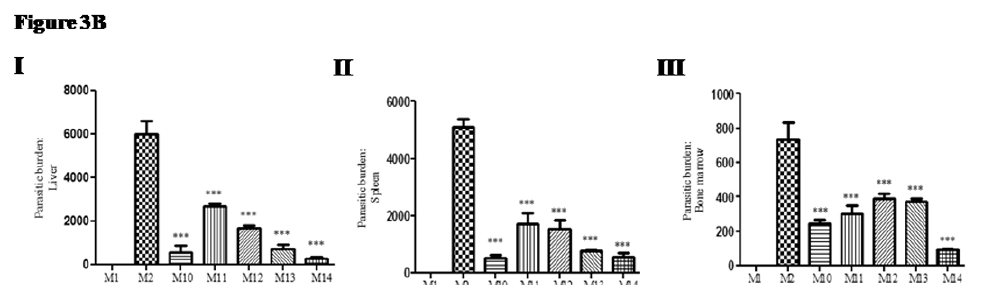
Fig. 3B. Adjunct therapy of recombinant cytokines (IL-17A and IFN- γ ) along with sub-optimal dose of AmpB, inhibit parasitic growth in visceral organs of Leishmaniadonovani infected mice: Giemsa stained slides of tissue specimen was used for parasite load estimation in visceral organs under the microscope (10 X 100). (I) Parasitic load in liver (II) Parasitic load in spleen(III) Parasitic load in bone marrow